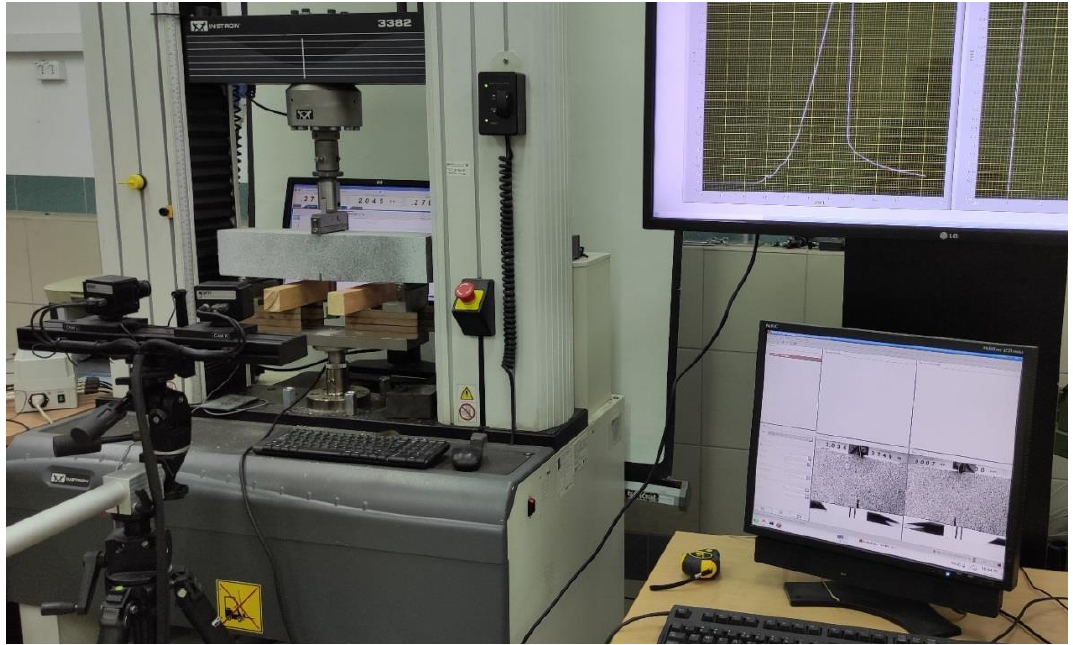
Figure 2. View of the test stand with the use of the ARAMIS 2M system by GOM. Due to the aim of the study, i.e., the observation of the development of cracks on the side surface of the sample, the loading process was controlled by the constant speed of the head displacement while loading the sample. During the test, the displacement of the head loading the sample (in mm), the response of the sample to the given displacement in the form of reaction force (in kN) and crack mouth opening displacement ( CMOD ) (in mm) in the middle of the sample span were recorded. CMOD was recorded using a sensor for measuring the increase in crack opening with a range of 10 mm with a resolution of 0.01 mm. Each sample was loaded with a head moving speed of 1 mm/min. This method of loading corresponds to the CMOD growth rate not exceeding 0.05 mm/min, i.e., recommended in the PN-EN 14651: 2007 standard. Readings were recorded at a frequency of 1